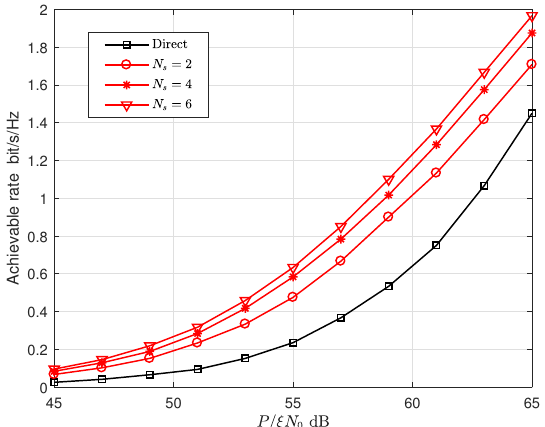
Figure 10. The achievable rate versus P / ( ξ N 0 ) with optimal power allocation and optimal relay location.